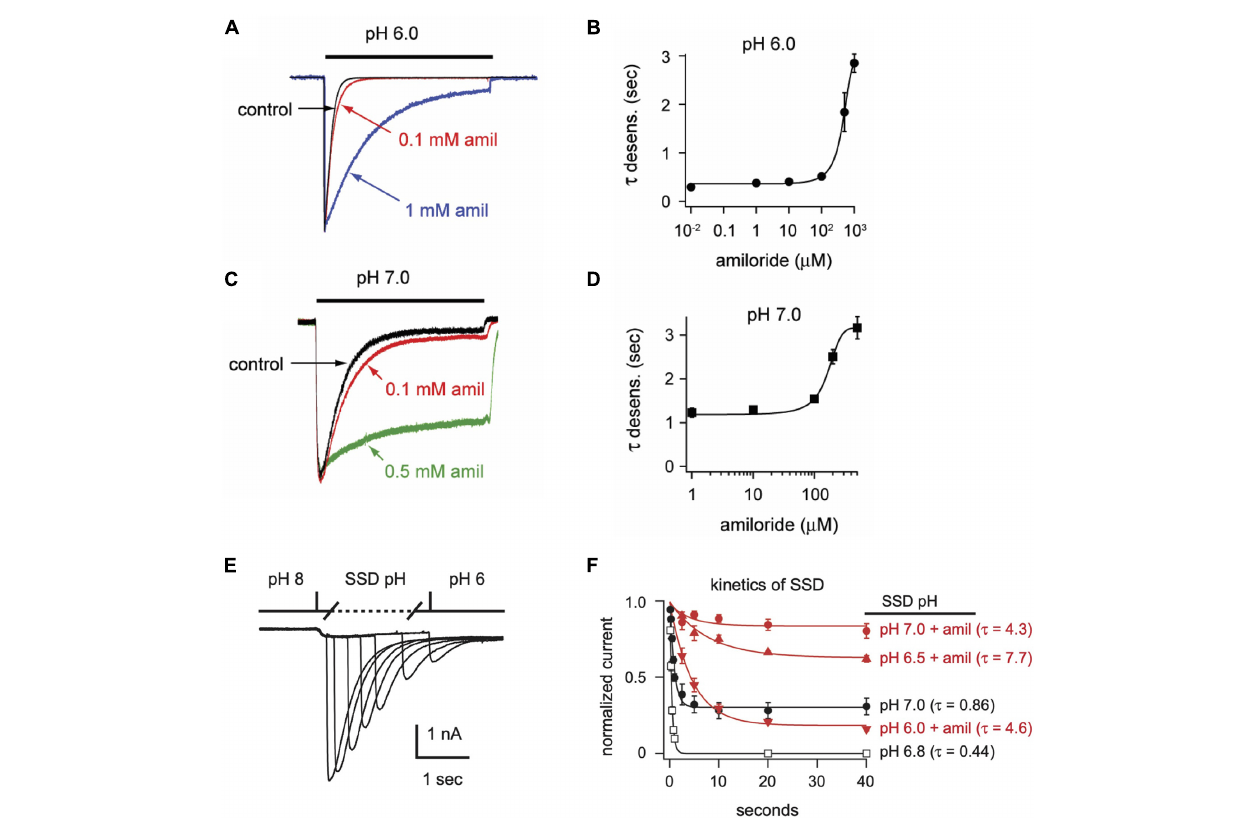
FIGURE 4 | Amiloride slows the rate of desensitization of ASIC3. Overlays of (A) pH 6- or (C) pH 7-evoked normalized currents in the absence (control) or presence of amiloride at the indicated concentrations. Acidic pH was applied for 10 s. Amplitudes of pH 6-evoked currents (nA): control 18.6, 0.1 mM 5.66, 1 mM 0.70; pH 7-evoked currents (nA): control 1.05, 0.1 mM 1.40, 0.5 mM 0.78. (B,D) Are the mean time constants of desensitization ( τ ) as measured from single exponential fits to the falling phase of pH 6- (B) and pH 7-evoked currents (D) in varying concentrations of amiloride ( n = 4–8 per data point). Lines are sigmoid fits. (E) An overlay of currents evoked by stepping from pH 8 to pH 7 solution for variable time periods (see X axis of F ), following by a pH 6 test application. This protocol measures the time to steady-state desensitization (SSD). (F) Mean data of the time to SSD as collected in E for currents that underwent SSD in the indicated pH solutions labeled at the right of each curve ( n = 3–10 per data point). Solutions with amiloride (red) contained 1 mM amiloride. Lines are fits of single exponentials of the means and time constants ( τ ) are shown.